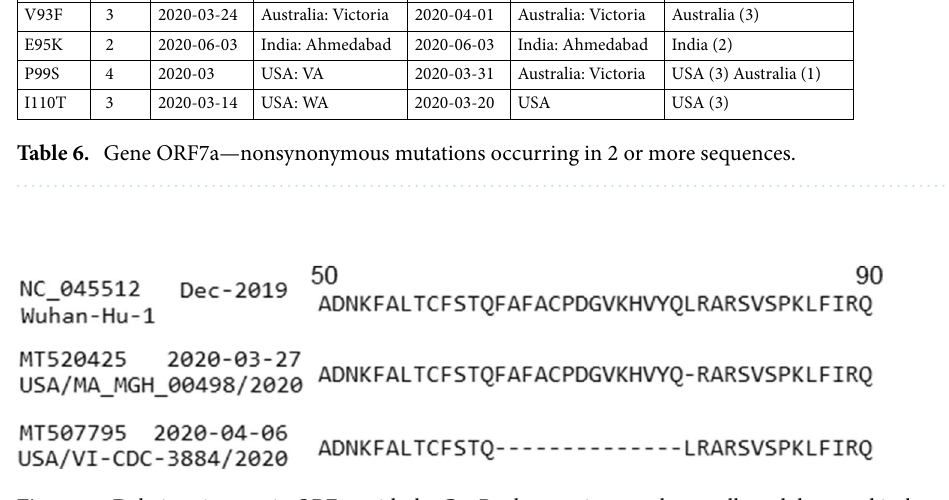
Figure 7. Deletions in protein ORF7a with the GenBank accession numbers, collected dates and isolate names presented on the left. The large 14 sequential deletions in the isolate USA/VI-CDC-3884/2020 (MT507795) are worth a further study as its patient’s clinical data may show some difference with other COVID-19